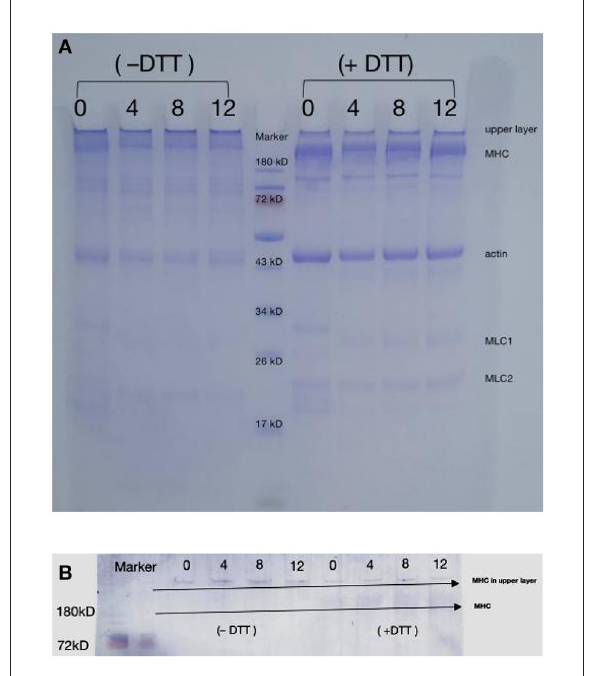
FIGURE2 Changes in SDS-PAGE patterns (A) and myosin heavy chain immunoblot (B) of duck myofibrillar proteins treated with various hydroxyl radical levels (H 2 O 2 concentrations: 0, 4, 8, 12 mmol/L). DTT means treated sample without dithiothreitol (DTT); + DTT means treated sample with dithiothreitol (DTT).